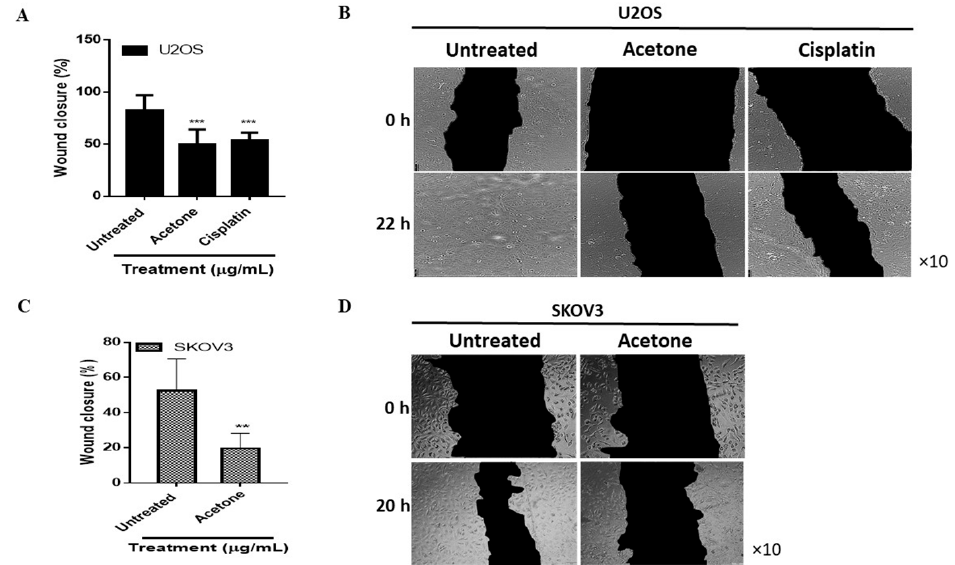
Figure 6. S. triloba acetone extract decreases wound closure in both U2OS and SKOV3 cells. Percentage wound closure was determined for both U2OS and SKOV3 cells after incubation with S. triloba acetone extract (IC 50 ) for 22 h and 20 h respectively using the scratch-wound healing assay. Wound closure was determined as a percentage of the wound area at the respective time point relative to the wound area at 0 h. ( A ) S. triloba acetone extract significantly decreased U2OS percentage wound closure by about 30% when compared with untreated controls; this decrease was similar to the one observed in the cisplatin control (IC 50 ). ( B ) Representative images depicting wound closure progression of U2OS cells. ( C ) Similarly, SKOV3 cells percentage wound closure was significantly decreased by about 32% after S. triloba acetone extract treatment. The paclitaxel control (IC 50 ) caused the SKOV3 cells around the wound boundaries to detach and percentage wound closure could not be accurately determined for these samples. ( D ) Representative images depicting wound closure progression of SKOV3 cells. Results are a representation of three independent experiments (*** p ≤ 0.001, ** p ≤ 0.01, * p ≤ 0.05).